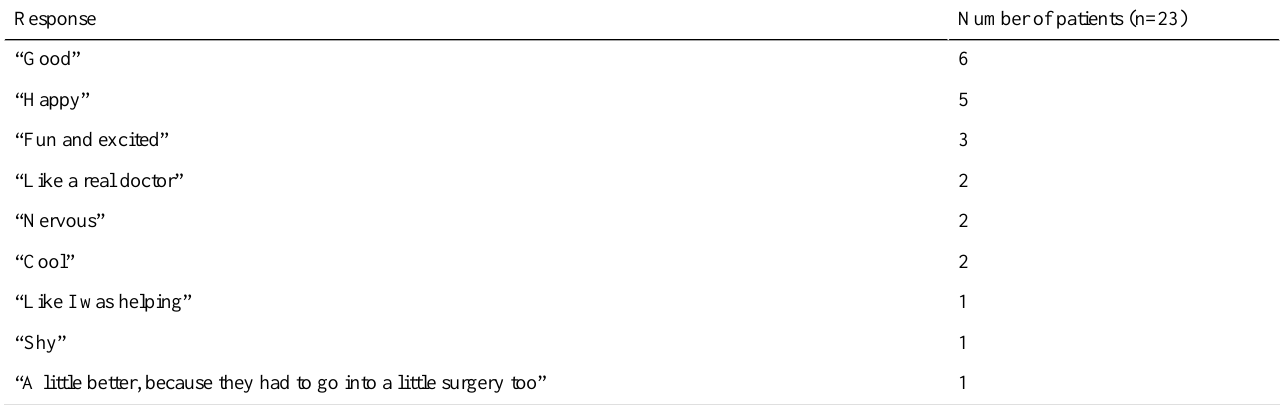
Table 2. Patients’ feelings during gameplay with DocVR, in response to the question “How did you feel while playing ‘Doc McStuffins: Doctor for a Day?’”